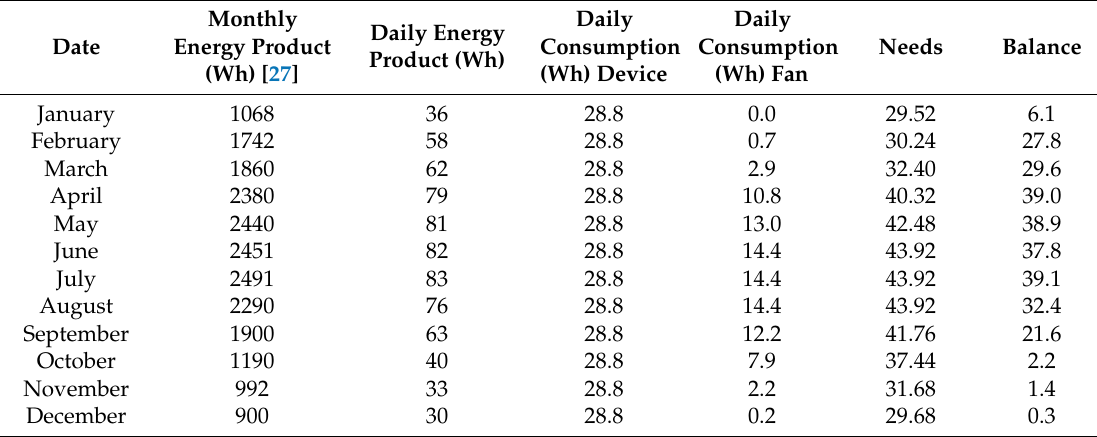
Table 1. Energy balance between production and consumption in the system.